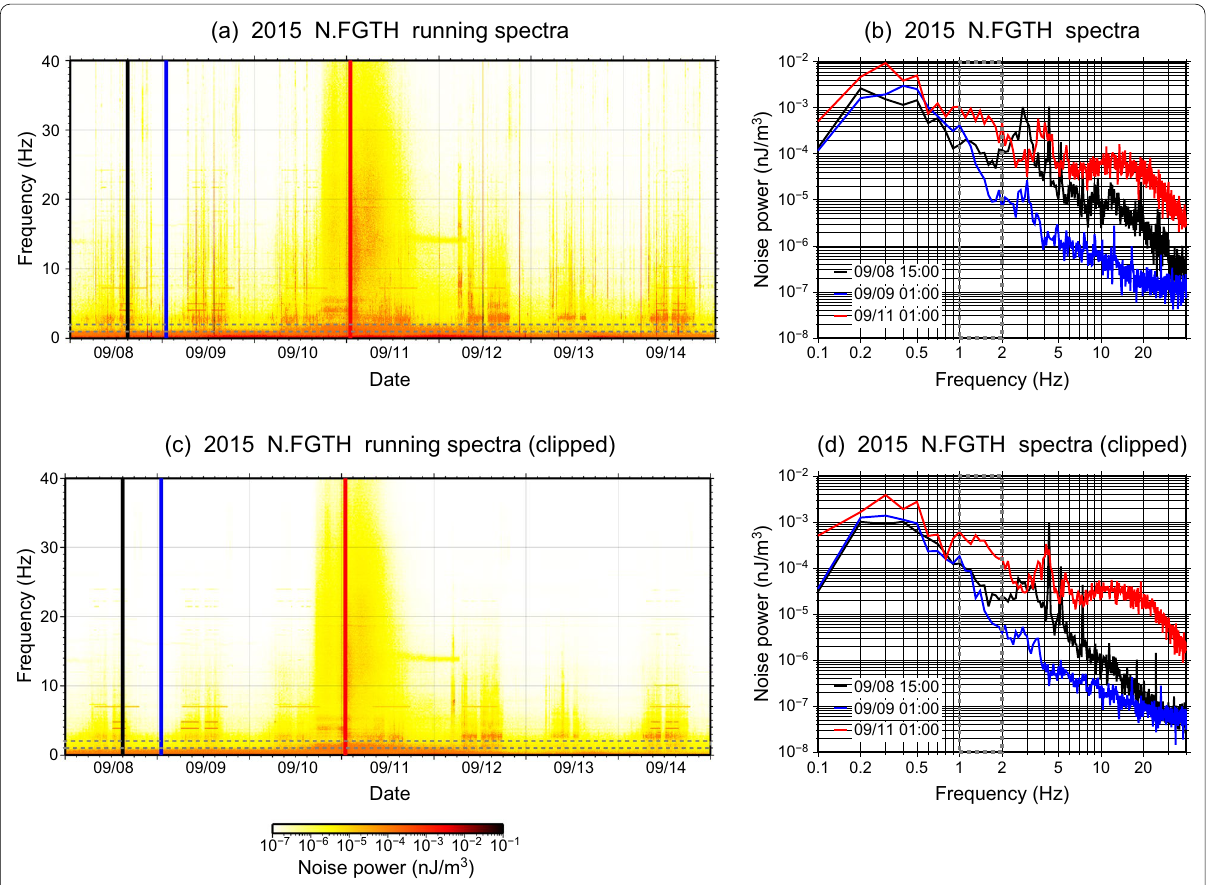
Fig. 4 Spectrograms of seismic noise recorded at the N.FGTH station for the event of September 2015. a Running spectra of the raw seismogram. b Spectra at the three time periods shown in ( a ), where black, blue, and red spectrum are obtained in the daytime, midnight, and peak streamflow periods, respectively. c Running spectra of the seismogram after “clipping” transient peaks (e.g., earthquakes). d Spectra at the three time periods shown in ( c ). The gray dashed lines in each panel represent the spectral window used for our analysis (1–2